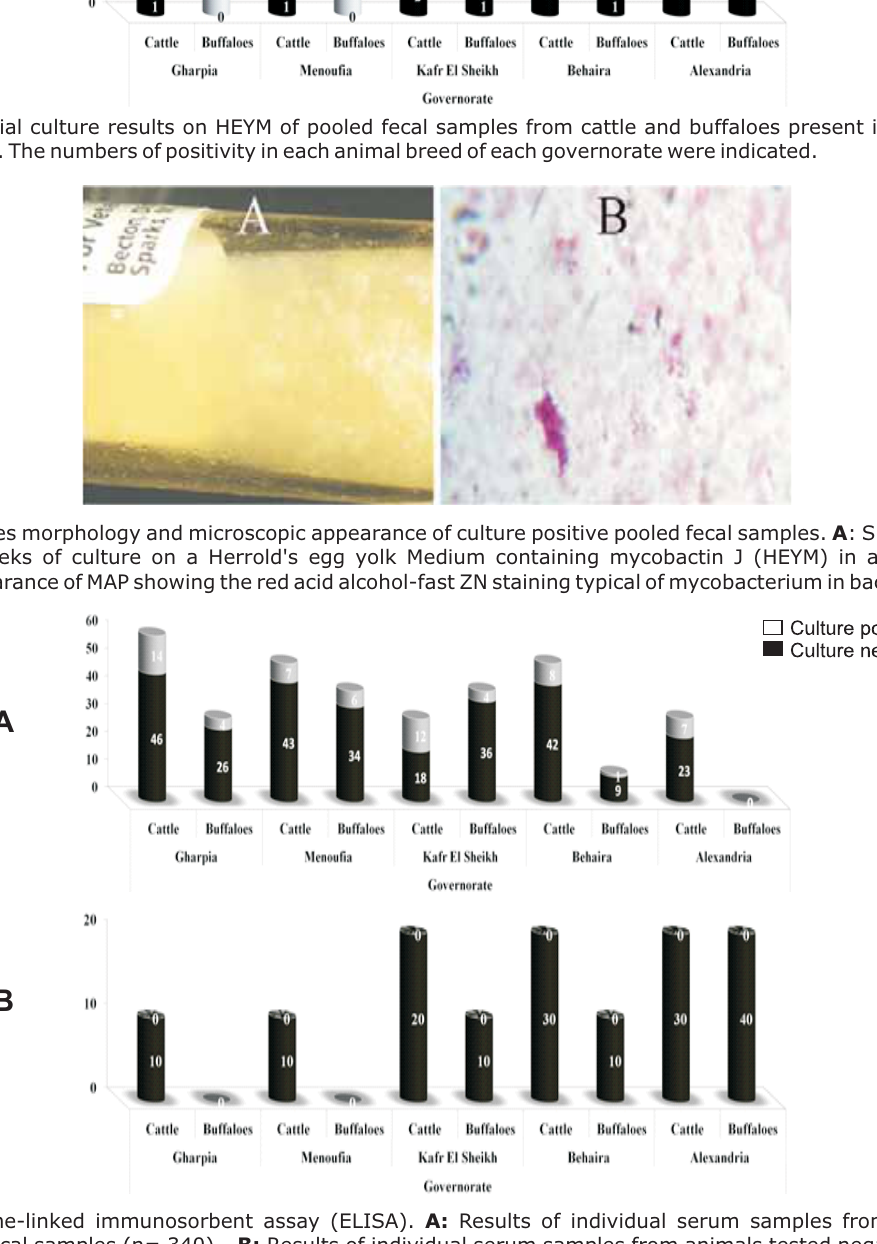
Figure-4: A: Enzyme-linked immunosorbent assay (ELISA). Results of individual serum samples from animals tested B: positive pooled fecal samples (n=